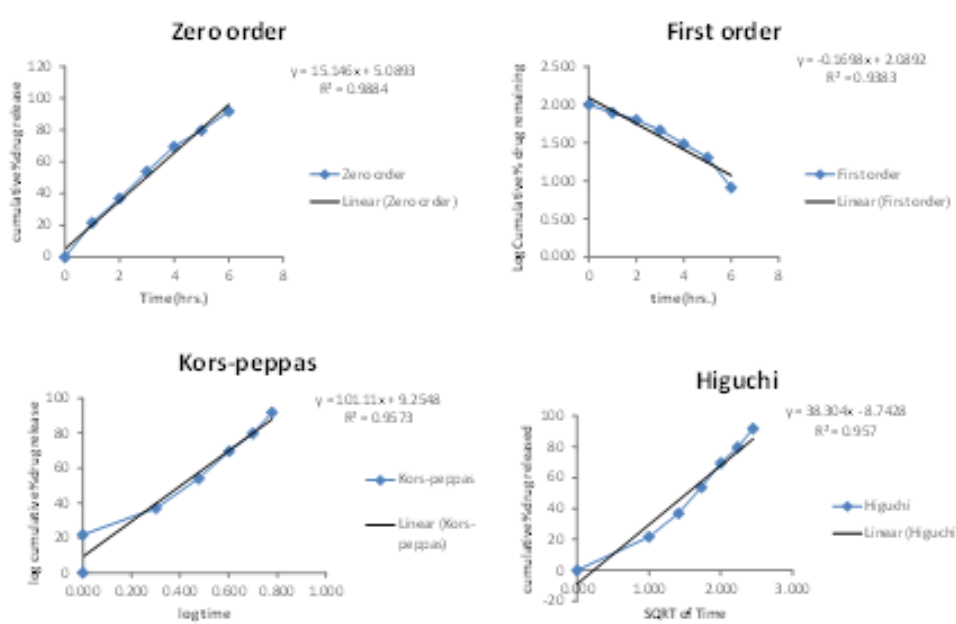
Figure 8. Drug release kinetics of β -sitosterol from optimised formulation F9.